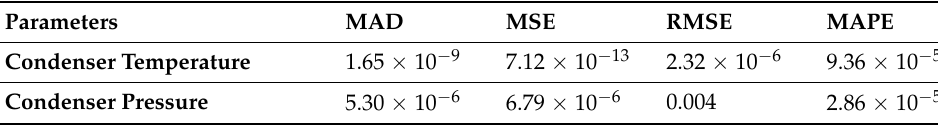
Table 6. Simulation results evaluation for condenser.